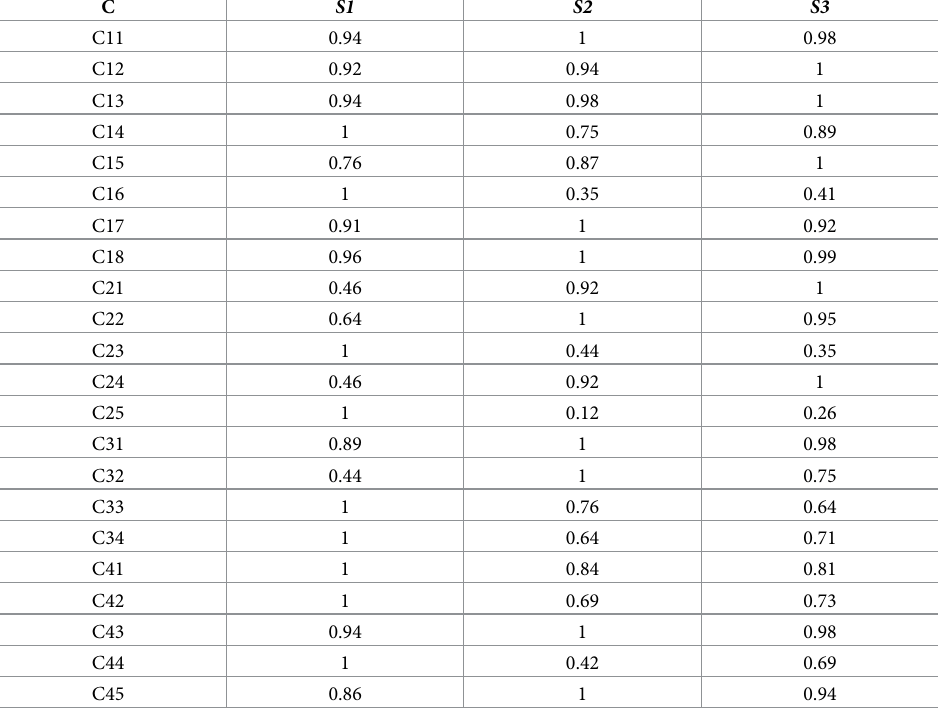
Table 5. Comprehensive weight vector of the judgement matrix.